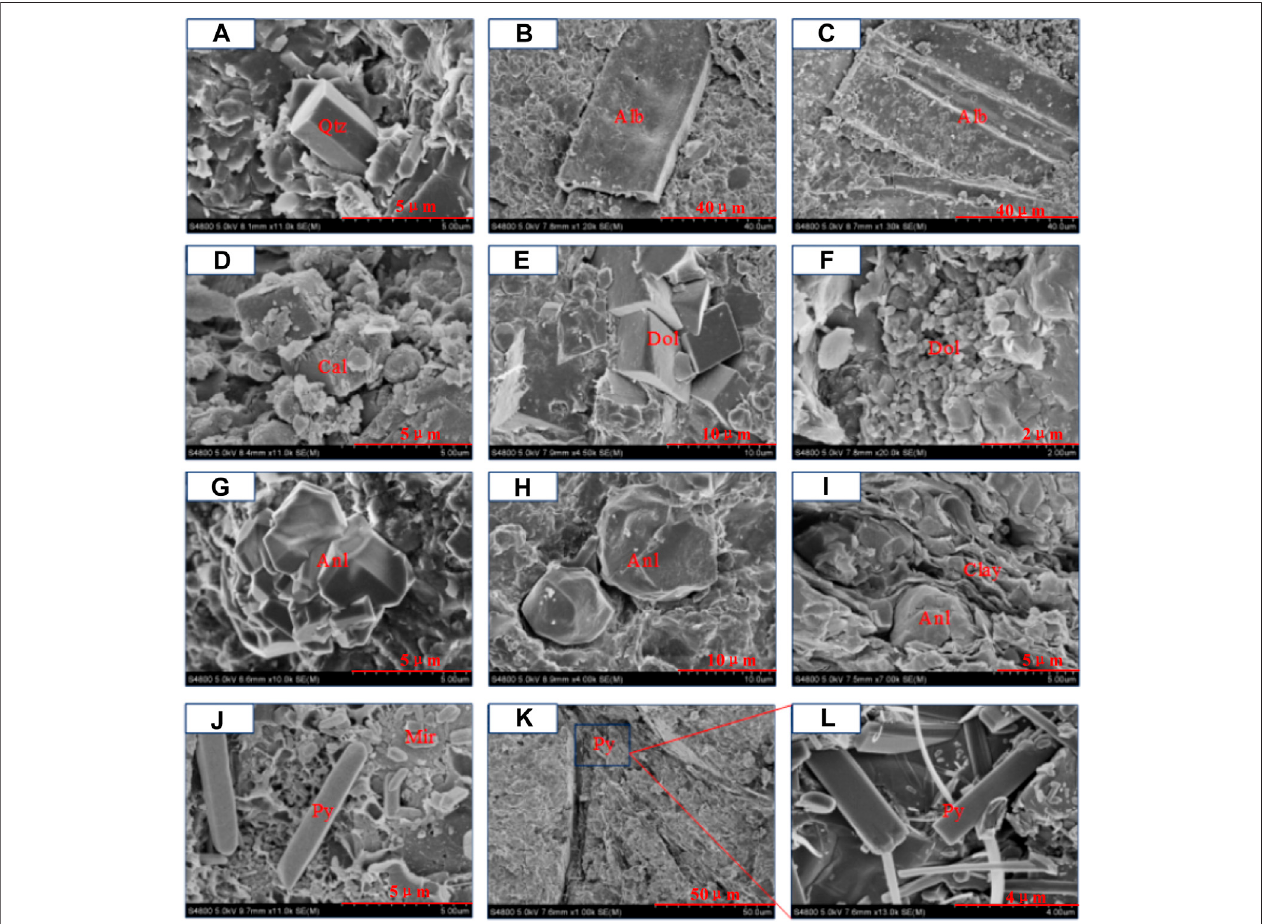
FIGURE 4 | Morphology observed of major minerals in shale samples under FE-SEM.